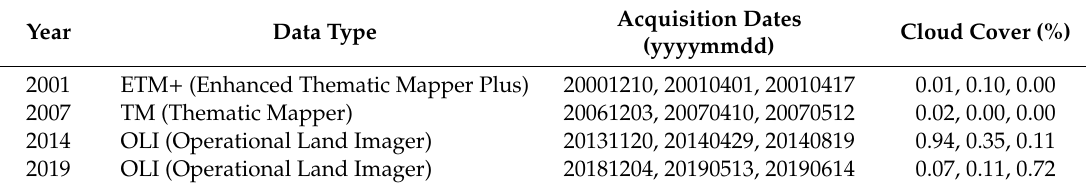
Table 1. Basic details of the Landsat images (Path 123 / Row 33) used in this